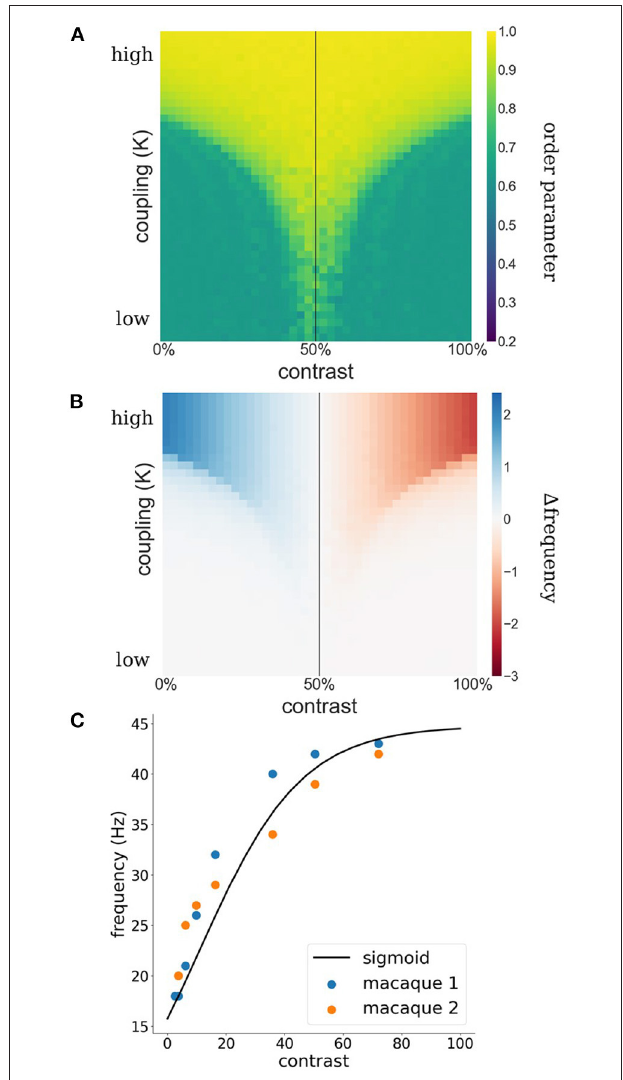
FIGURE 1 | (A) Phase coherence between two WCOs. The contrast input to the first, reference, oscillator is fixed at 50% (black vertical line) whereas the contrast input to the second oscillator varies (x-axis) leading to detuning between their intrinsic frequencies. Coupling strength between the two oscillators varies along the y-axis. A tongue-shaped region (yellow) indicates where the pair of oscillators synchronizes. (B) Difference between observed (mean effective frequency) and intrinsic frequency of the reference oscillator. Within the synchronization region, the reference exhibits an increased frequency when its intrinsic frequency is lower than that of the second oscillator (blue) and a decreased frequency when its intrinsic frequency is lower than that of the second oscillator (red). (C) Estimation of contrast-frequency relationship from electrophysiological data. Colored dots represent peak frequency of empirically measured LFPs as a function of stimulus contrast (blue and orange dots represent data of two individual monkeys). The solid line reflects the best fitting sigmoid